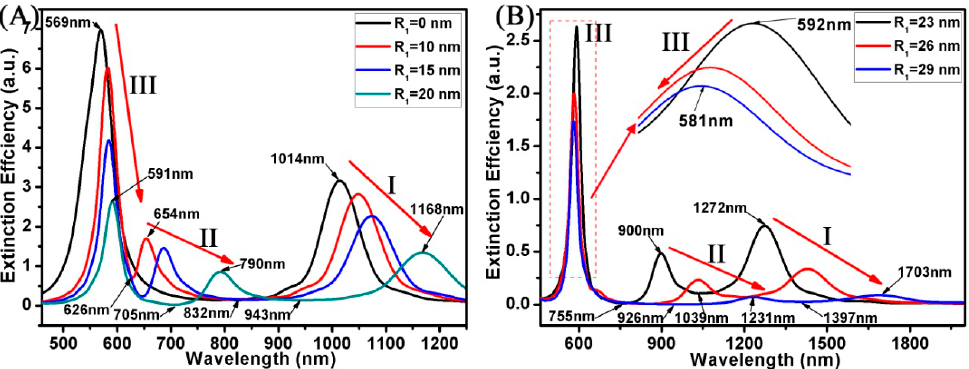
Figure 3. ( A , B ) Spectra calculated for the Au ring-disk nanostructures with different R 1 . The R 2 of the ring was unchanged (R 2 = 30 nm). The R 3 of the disk was unchanged (R 3 = 30 nm). The H of the ring-disk nanostructures was unchanged (H 1 = H 2 = H = 10 nm). The R 1 of the ring increased from 0 to 29 nm. Figure 4 displays the extinction spectrum of the Au ring ‐ disk nanostructures with different R 2 .